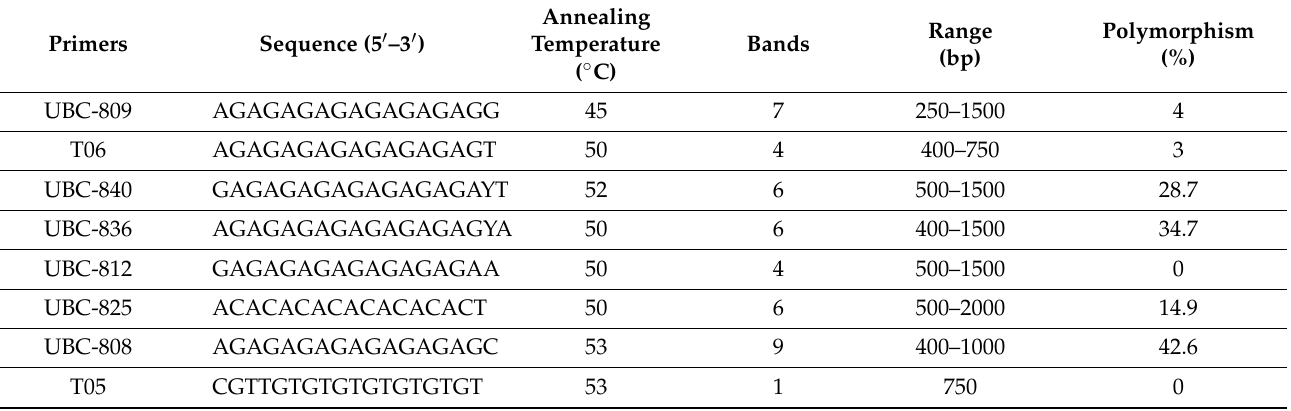
Table 1. Inter simple sequence repeat (ISSR) molecular markers selected to evaluate the somaclonal variation of vanilla ( Vanilla planifolia Jacks. ex Andrews) at different doses of gamma irradiation with 60